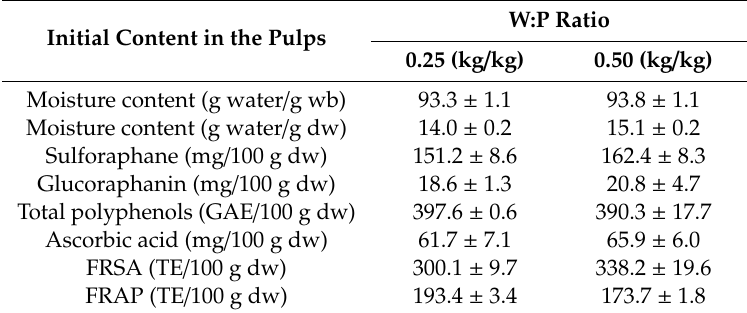
Table 2. Content of bioactive compounds of the pulps before drying.